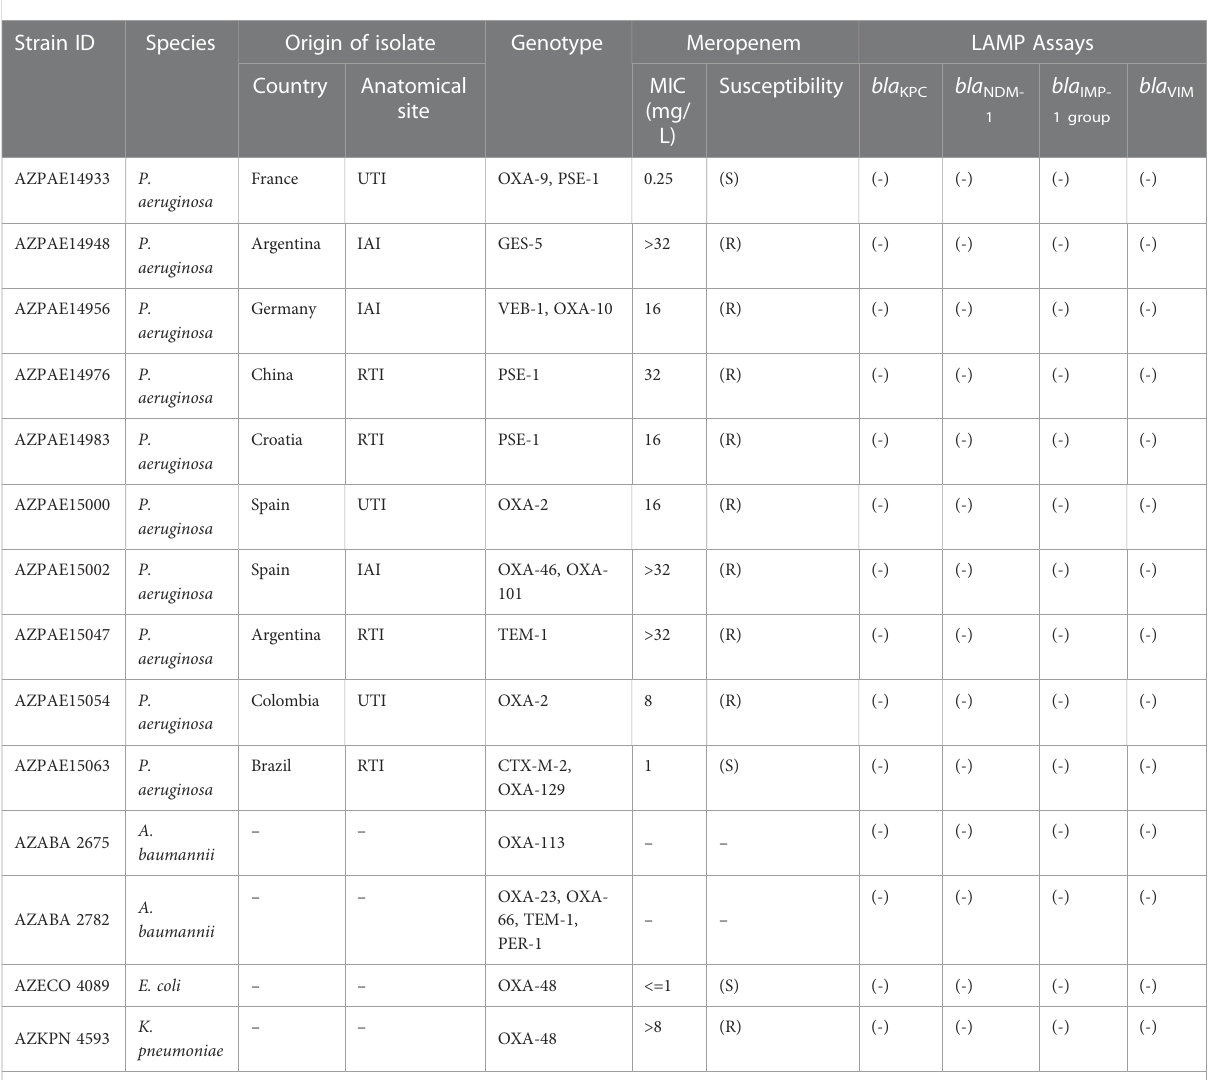
Supplementary Table 1. The alignments of the four target genes are shown in Supplementary Figure 1.